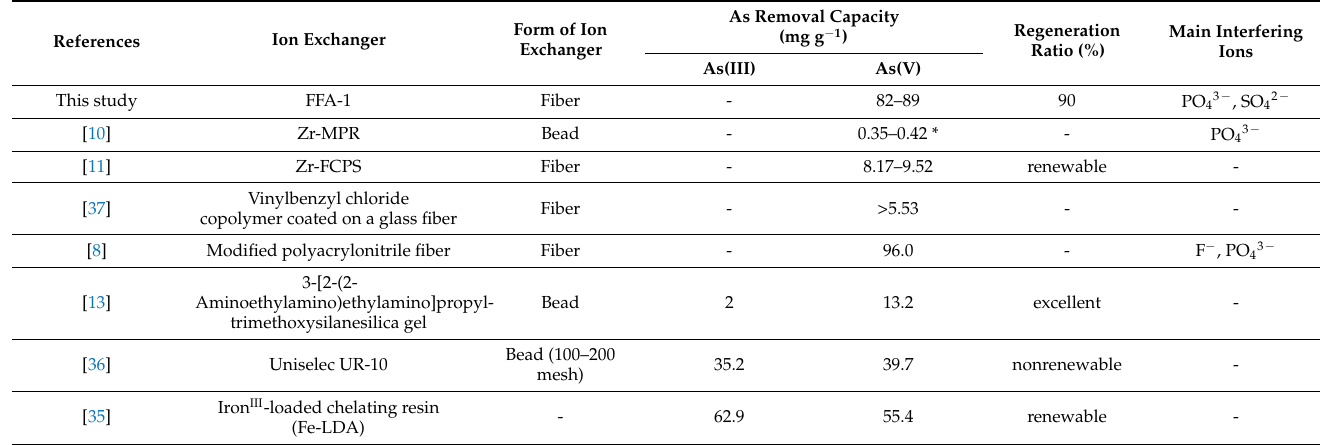
Table 2. Comparison of As removal capacity via different ion